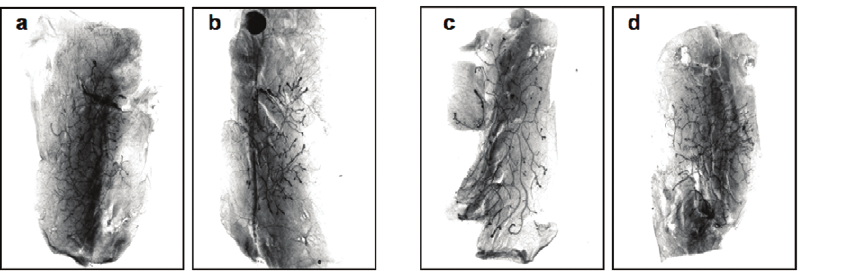
Figure 5. Transplantation results from implantation of dispersed, aged-nulliparous and aged-multiparous mammary epithelial cells into mammary fat pads of 3-wk old female mice. Representative whole-mounts of FVB/N-RC cleared fat pads transplanted with 250 (panel a and b) or 100 cells (panel c and d), collected from aged-nulliparous (panel a and c) and aged-multiparous (panel b and d), showing outgrowth filling of the fat pad. There was no difference in the results obtained with tissues from aged versus young donors regardless of parity.